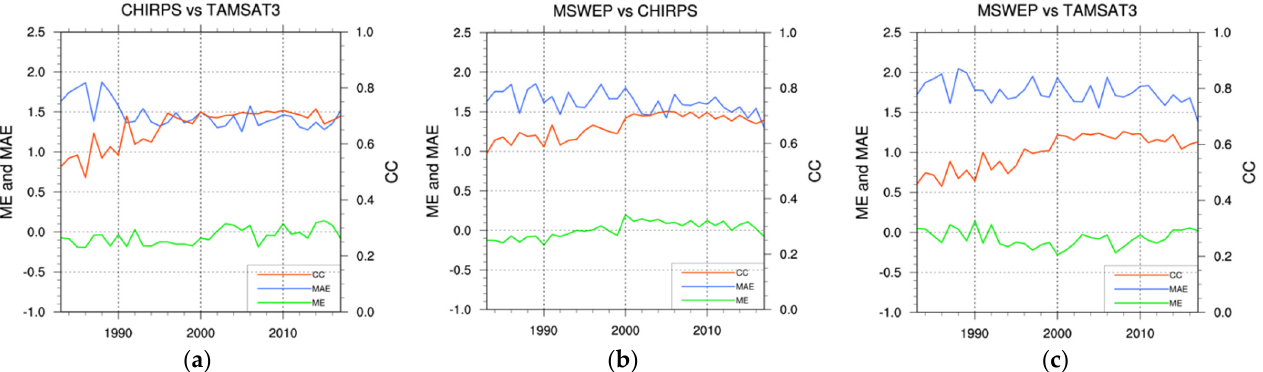
Figure 18. Same as in Figure 15 but for SA: TAMSAT3 with respect to CHIRPS ( a ), MSWEP with respect to CHIRPS ( b ) and TAMSAT3 with respect to MSWEP ( c ).